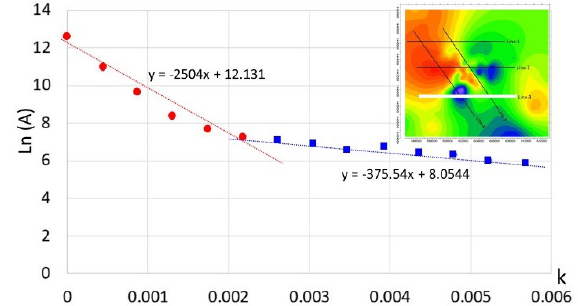
Fig. 8. Bouguer anomaly spectrum analysis to determine the depth limits of regional and residual anomalies. The spectrum analysis results for line 2 get the depth limit value of the residual regional Bouguer anomaly of 2504 = 2500 m.